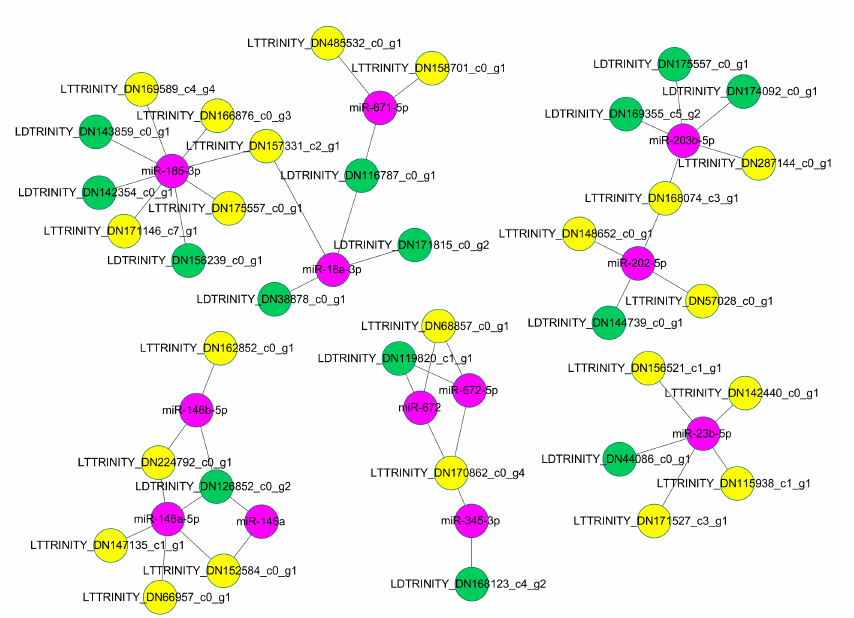
Figure 7. Representative regulatory networks of miRNA-lncRNA duplexes. Pink nodes, miRNAs; yellow nodes, lncRNAs that may be miRNA targets; green nodes, lncRNAs that may be miRNA target mimics. The labels of nodes were prefixed with specific abbreviations, such as MT for mRNA target, LT for lncRNA target, MD for mRNA mimics, and LD for lncRNA mimics. Grey edges: